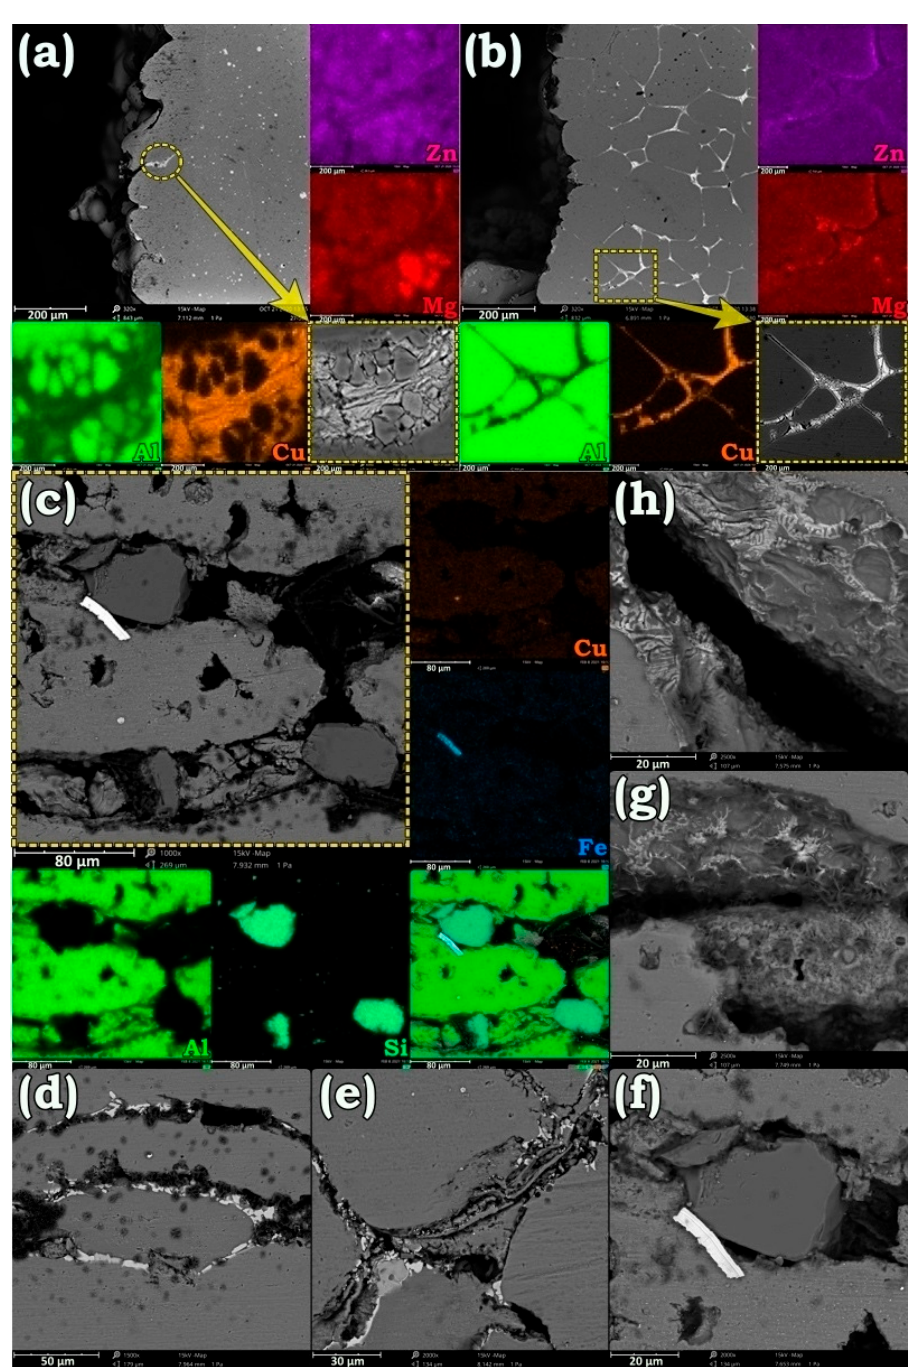
Figure 8. SEM images and elemental map analysis of the phases formed around the failure edge of AA7475-AA2198 ( a , b ) and AA6013-AA2198 ( c – h ) welds after annealing at 580 °C for 1 h. The failure surface of the AA7475-AA2198 from the TMAZ/SZ interface after anneal- ing at 560 and 580 °C are presented in Figure 9a–f and Figure 9g–i, respectively. As can be